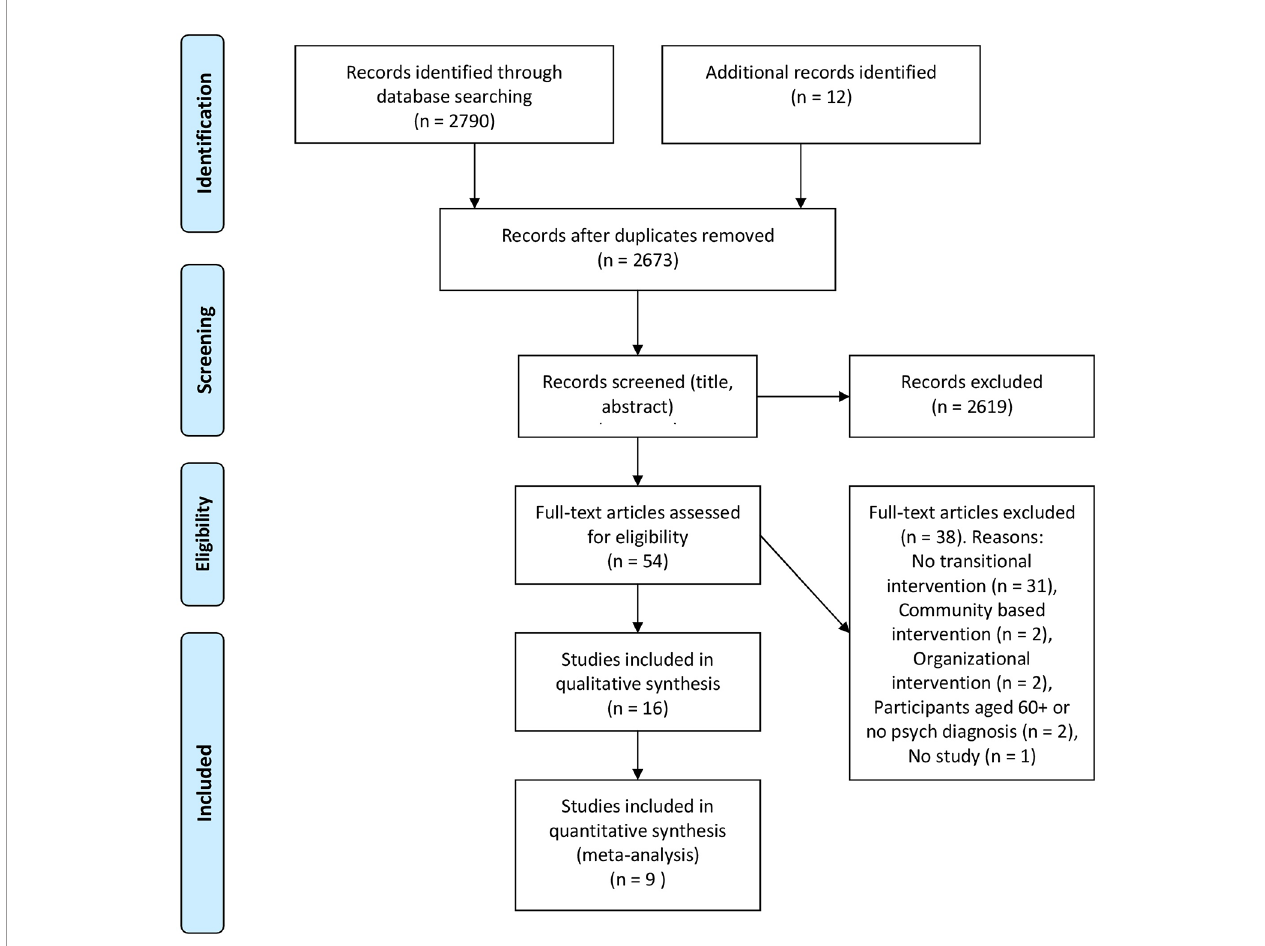
FIGURE 1 | Flow diagram of study selection